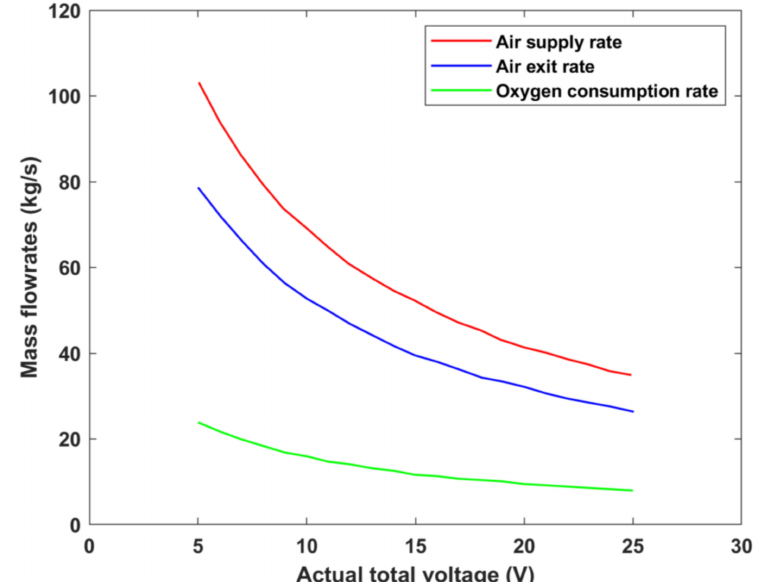
Figure 12. Variation in oxygen consumption rates and air flowrates with operating cell voltage.